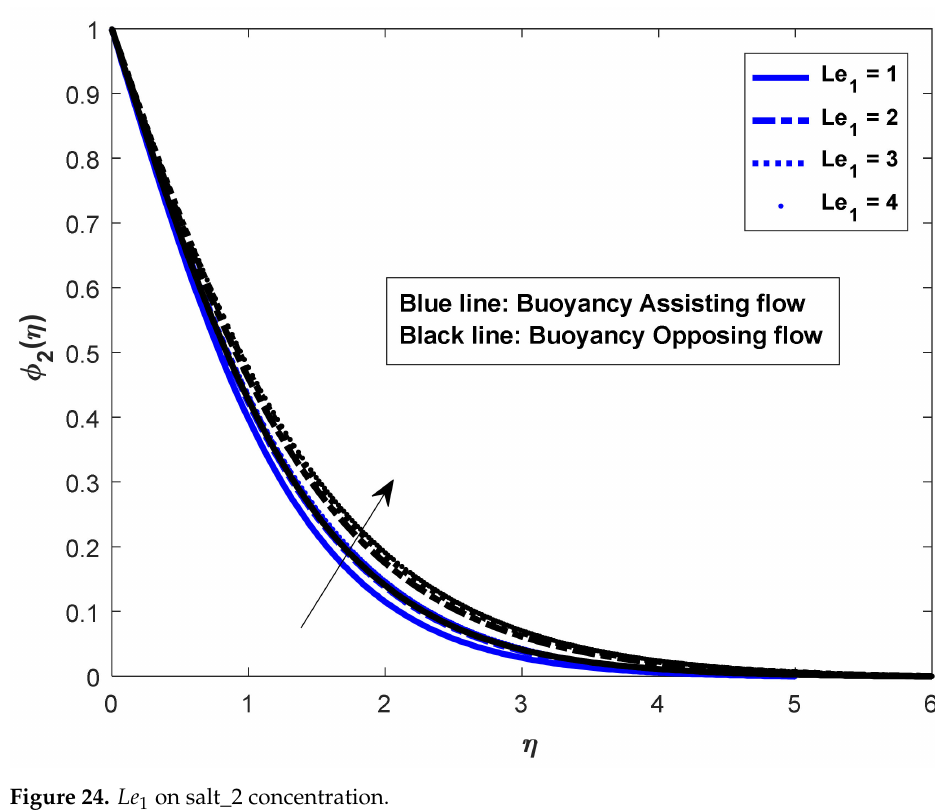
Figure 24. Le 1 on salt_2 concentration.